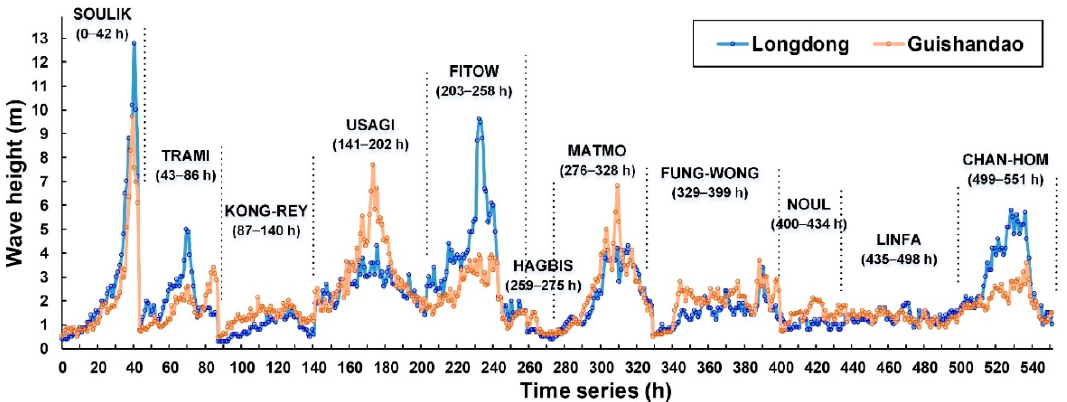
Figure 3. Observation record of the significant wave height of the 11 typhoons in the testing set.